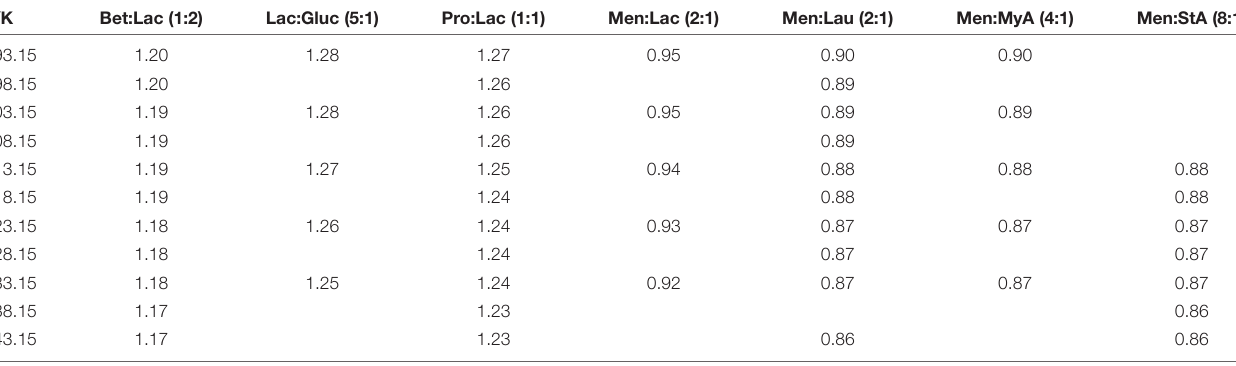
TABLE 3 | Experimental densities, ρ , expressed in g/cm 3 , of the DESs:Betaine lactic acid Bet:Lac (1:2), lactic acid glucose Lac:Gluc (5:1), proline lactic acid Pro:Lac (1:1), menthol lactic acid Men:Lac (2:1), menthol lauric acid (2:1), menthol myristic acid Men:MyA (4:1), and menthol stearic acid (8:1).